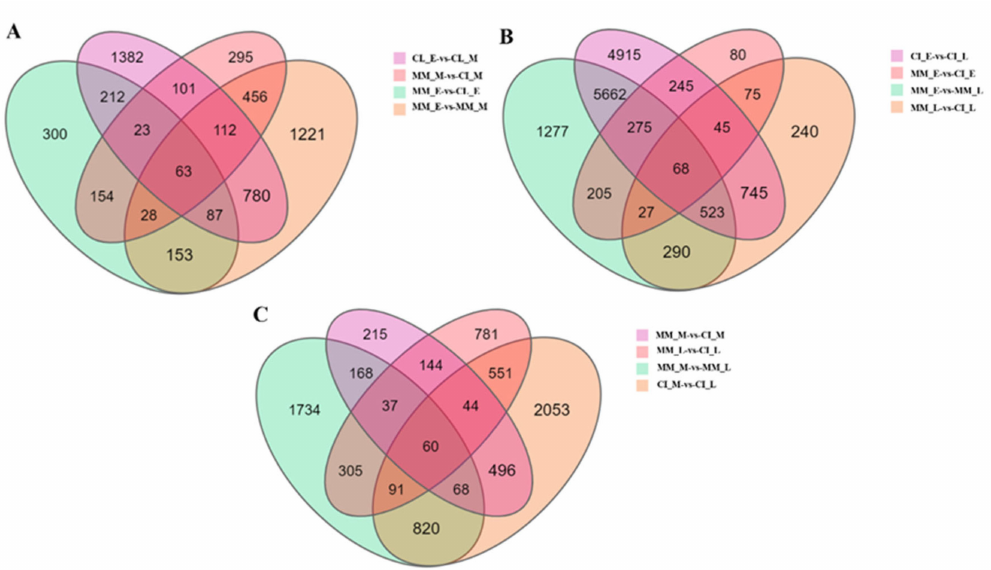
Figure 3. Venn diagram of 9 groups of DEGs. ( A ) Venn diagram of DEGs identified in the MM_E vs. MM_M, CI_E vs. CI_M, MM_E vs. CI_E and MM_M vs. CI_M comparisons. ( B ) Venn diagram of DEGs identified in the MM_E vs. CI_E, MM_L-vs. CI_L, MM_E vs. MM_L and CI_E vs. CI_L comparisons. ( C ) Venn diagram of DEGs identified in the MM_M vs. MM_L, CI_M vs. CI_L, MM_M vs. CI_M and MM_L vs. CI_L comparisons. Each circle represents a set of genes, and the overlapping regions of different circles represent the coexpressed genes.